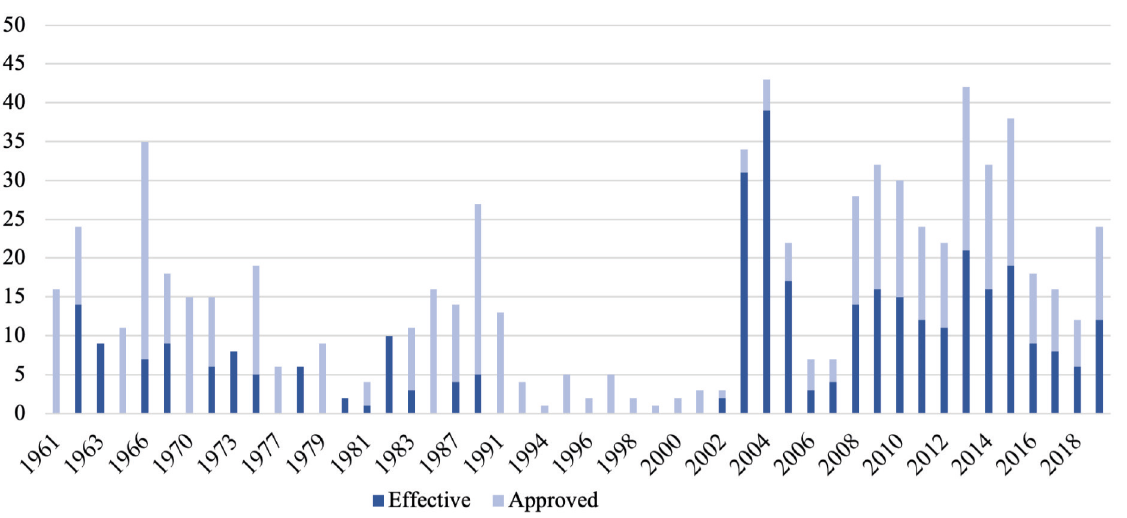
Figure 4. Recommendations and measures approved and made effective in Consultative Meetings from 1961 and